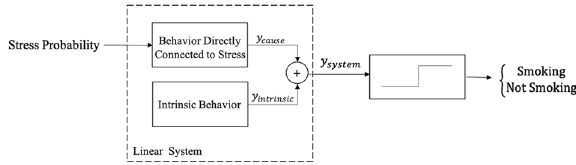
Fig. 2 System con fi guration for dynamical model that integrates a linear system and a nonlinearity.